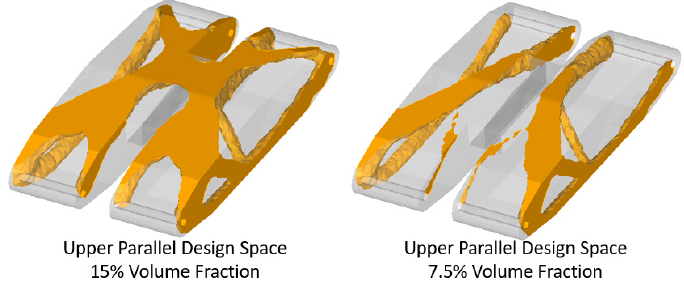
Figure 4. Upper parallel design space—comparing 15% and 7.5% volume fractions.